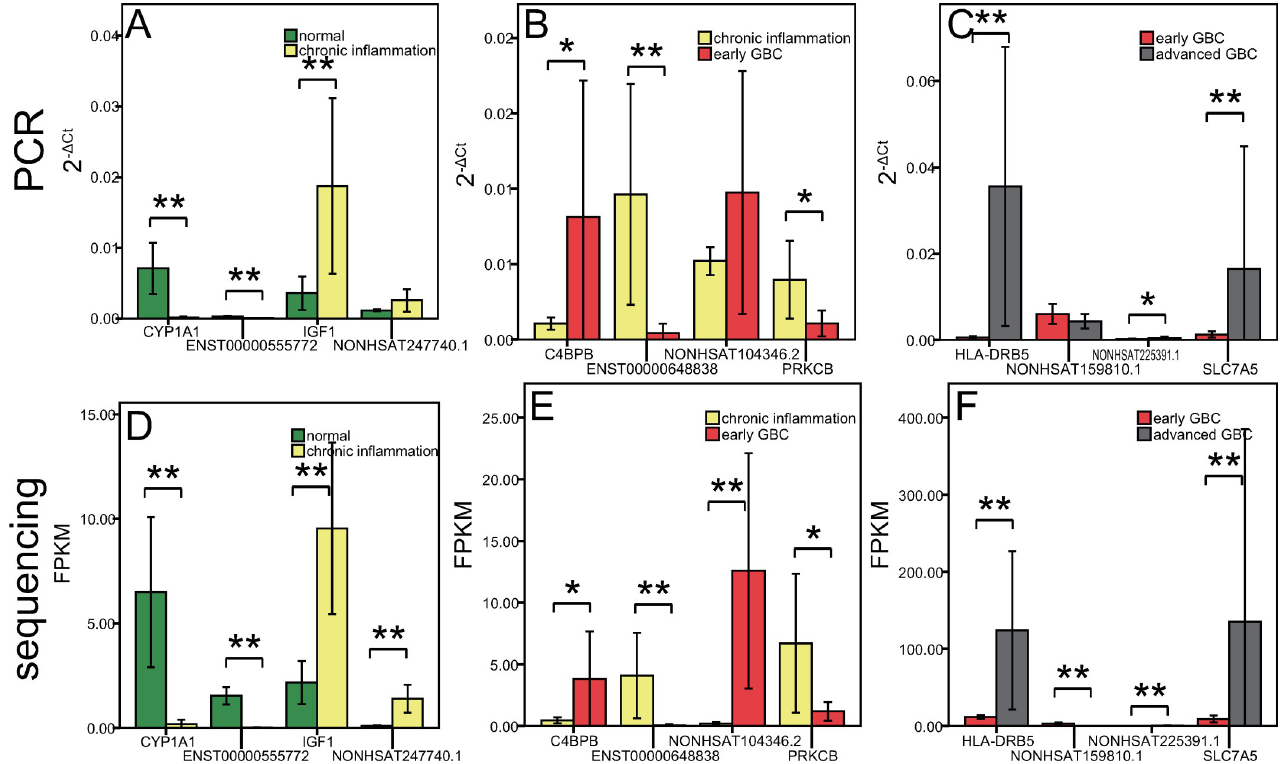
Fig 1. Verification through quantitative real-time PCR experiment. The first row of three graphs are the results of the qPCR experiment. The X axis represents each gene, and the Y axis represents the relative expression of each gene in the PCR experiment, represented as 2 - Δ Ct mean ± standard deviation. The second row of three graphs are the results of the RNA sequencing experiments. The X axis represents each gene, and the Y axis represents the relative expression of each gene in the sequencing experiment, represented as FPKMmean ± standard deviation. (A) and (D) are the results of the four genes selected in the comparison between normal gallbladder and chronic inflammation gallbladder. (B) and (E) are the results of the four genes selected in the comparison between chronic inflammation gallbladder and early GBC. (C) and (F) are the results of the four genes selected in the comparison between early GBC and advanced GBC. � P � 0.05 � � P �